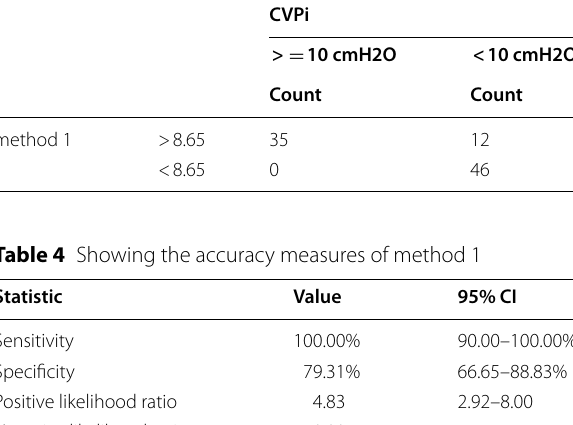
Table 3 For classification by the cut‑off value in method 1